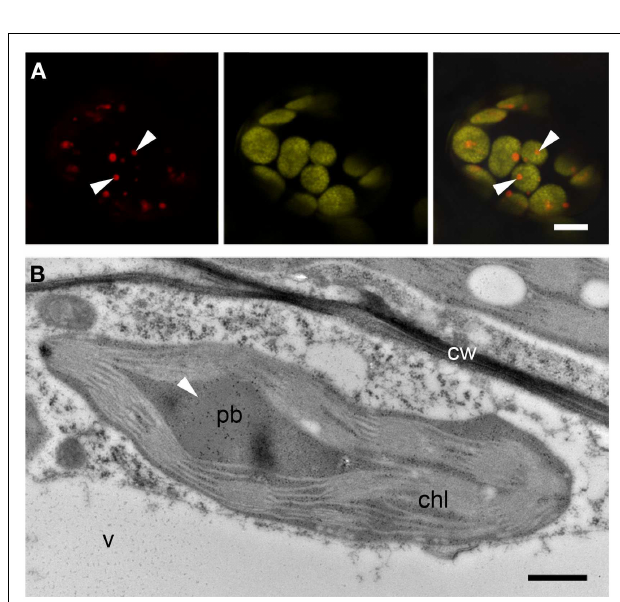
FIGURE 3 | Protein body formation in the ER (SP) . (A) Confocal laser scanning microscopy. Infiltrated leaf tissue overview, showing abundant protein bodies.The inset shows an enlargement of the outlined protein body cluster. (B,C) Electron microscopy. Spherical